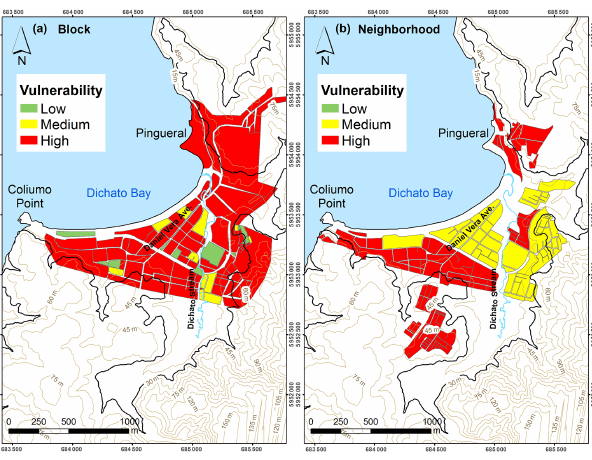
Figure 7. Master plan for reconstruction for Dichato.